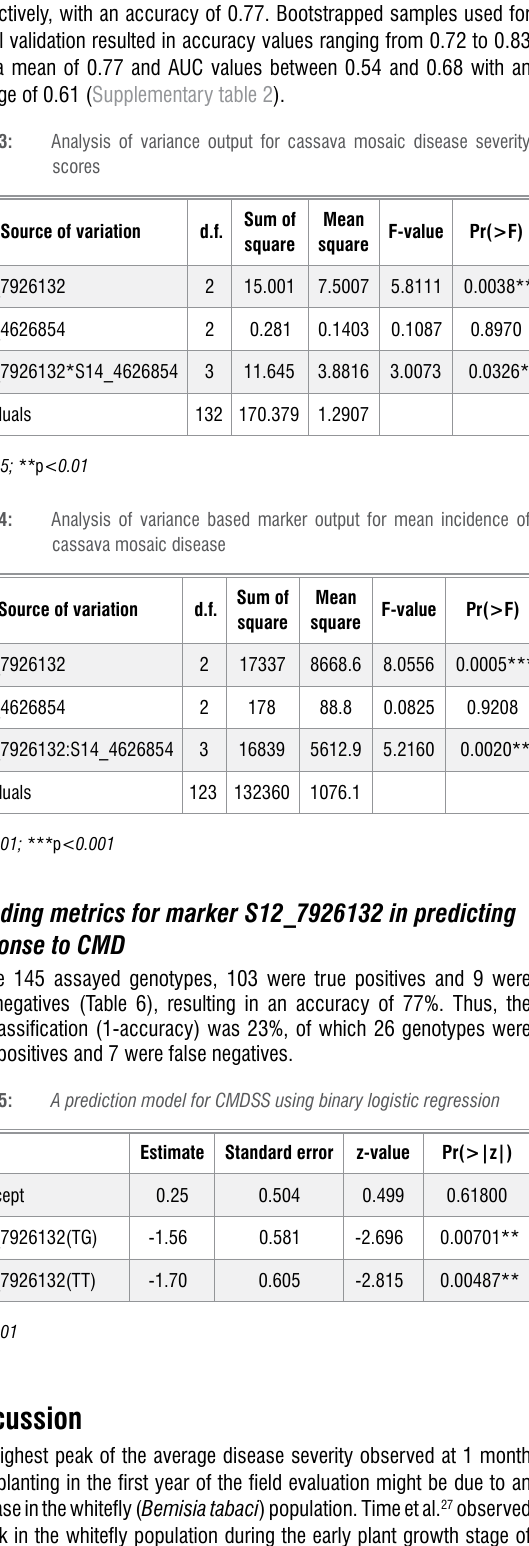
Table 6: Confusion matrix and derived metrics for mosaic disease severity among cassava genotypes evaluated in Ibadan in two seasons Prediction by the marker